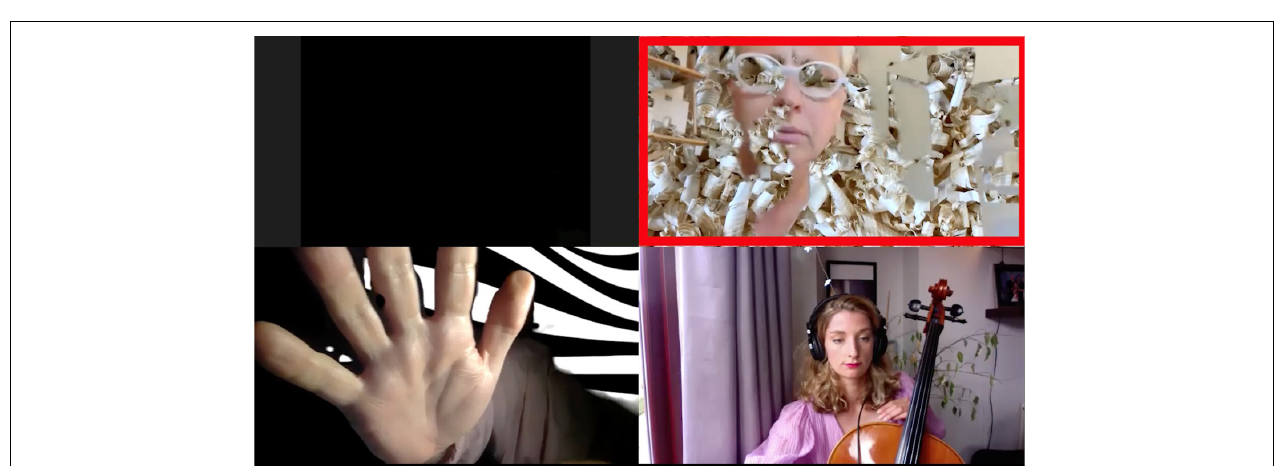
FIGURE 3 | Player multiplied across “boxes.”